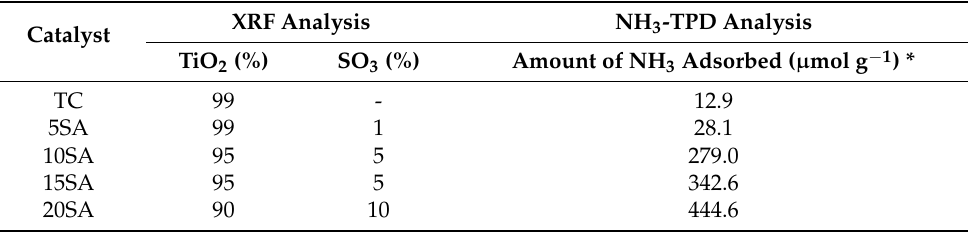
Table 2. The elemental analysis and surface acid distribution of non-sulphated and sulphated catalyst.